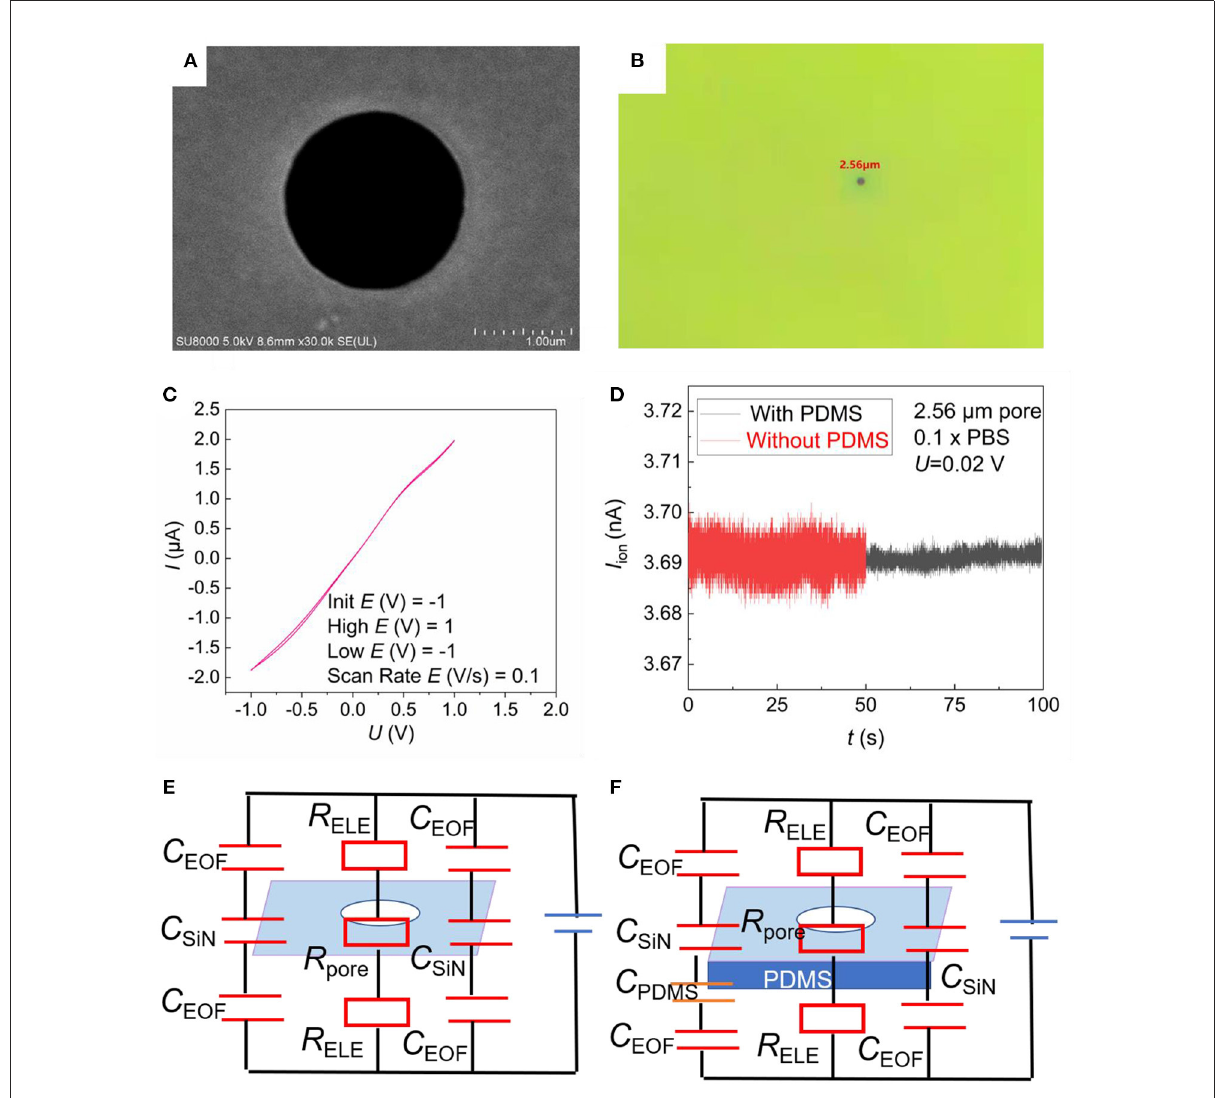
FIGURE3 Characterization of SiN chips. (A) SEM photo image of a single pore on the SiN chip. (B) Optical photo image of single pore on the SiN chip. (C) Cyclic voltammograms of SiN chip recorded in the presence of 10mM KCl as the electrolyte by a pair of Ag/AgCl electrodes. (D) I – t curve diagram of 2.56 µ m SiN single pore chip with 0.1 × PBS buffer. (E,F) Equivalent circuits of the SiN-sensing system without PDMS (E) and with PDMS (F) .